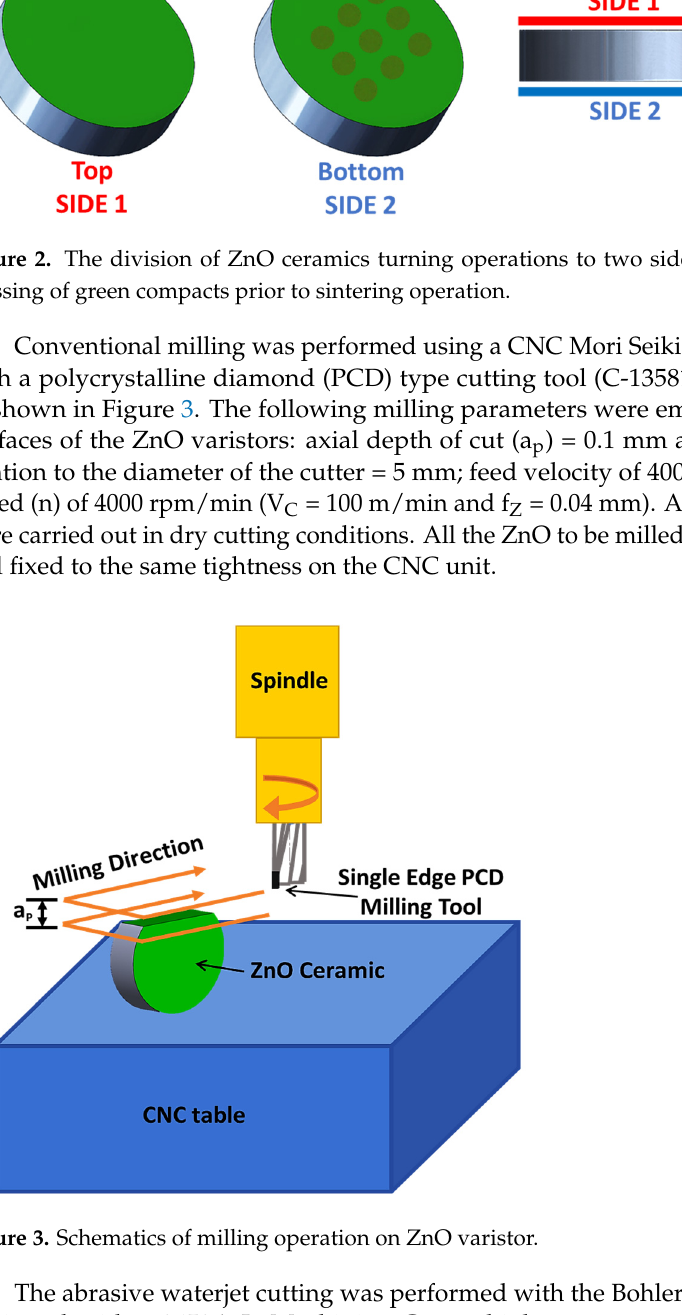
Figure 3. Schematics of milling operation on ZnO varistor.